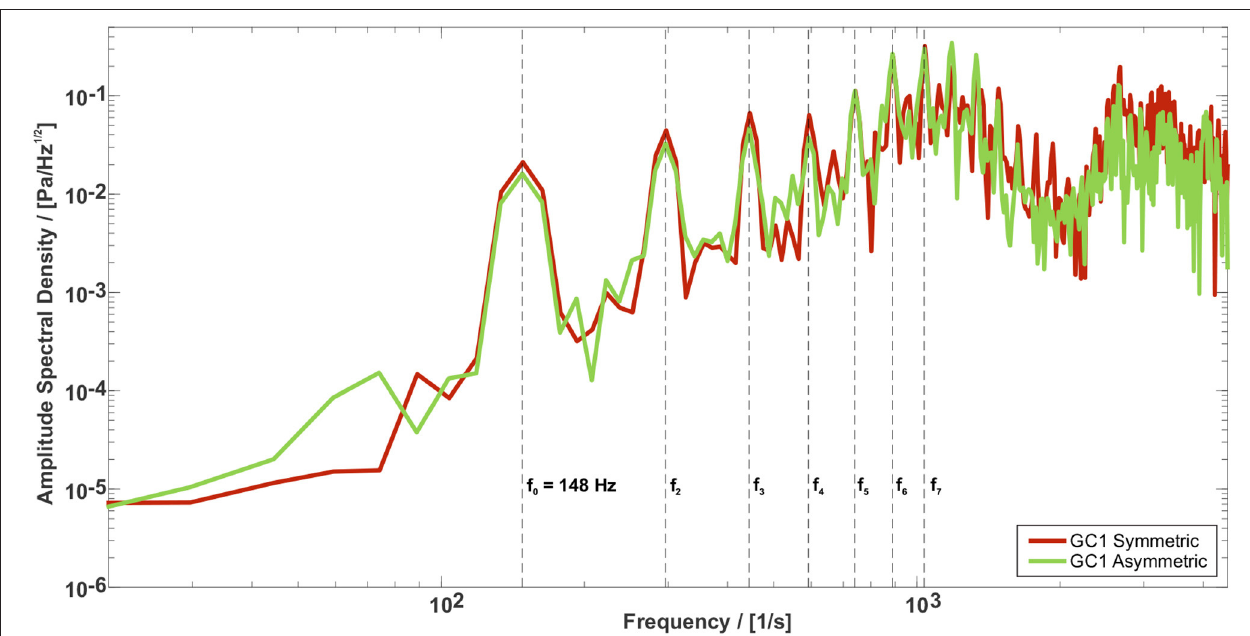
FIGURE 9 | Amplitude Spectral Density (ASD) for the GC1 type for the symmetric and asymmetric vocal fold motion. The spectra of both motions show similar slope and only slight deviations in the amplitudes at the fundamental frequency, whereas more significant differences occur at higher